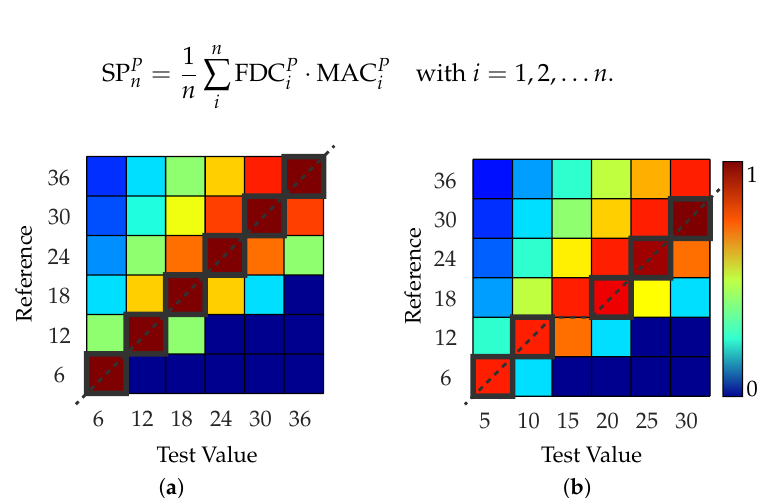
Figure 6. Frequency deviation correlation for ( a ) identical and ( b ) different pairs of input values and highlighted maximum correlation values in grey.